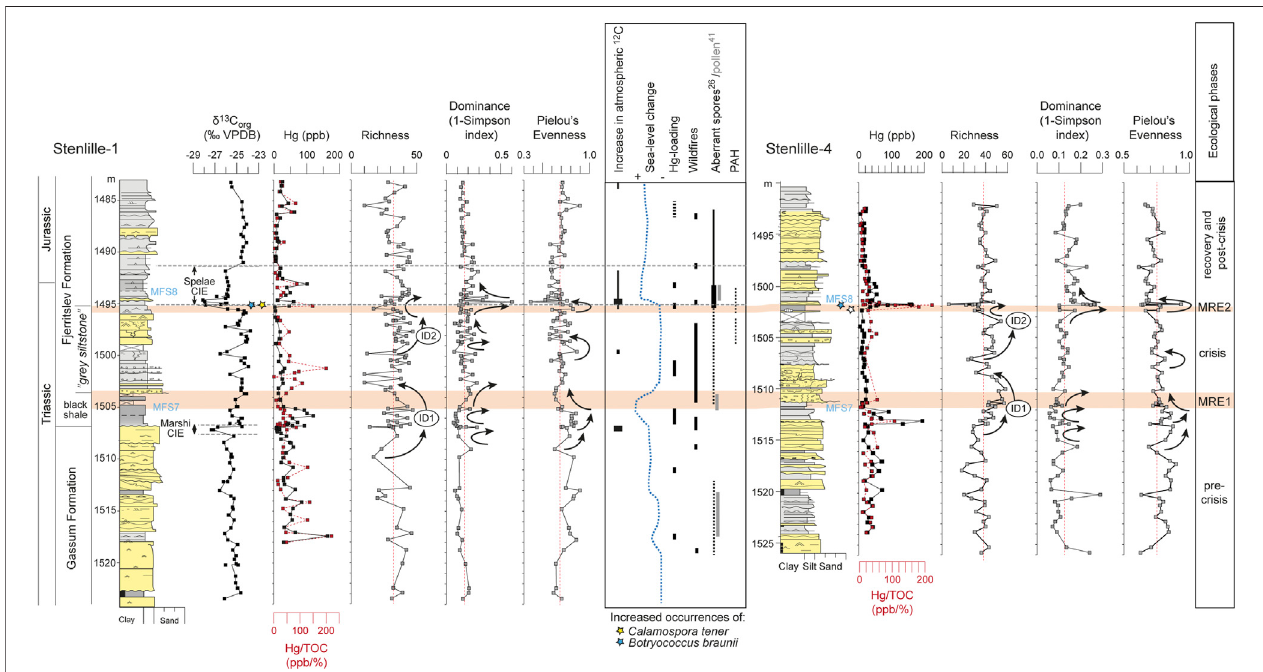
FIGURE 4 | Comparison of species richness, dominance (1-Simpson index), and Pielou ’ s evenness in Stenlille-1 and Stenlille-4. ID1 and ID 2 refer to two intervals with increased to maximum values in species richness indicate intermediate disturbance (Connell, 1978; Svensson et al., 2012). Hg and Hg/TOC records have been interpreted to re fl ect volcanic pulses of the CAMP (Lindström et al., 2021). Thin stippled red lines indicate mean level of the respective diversity indices.